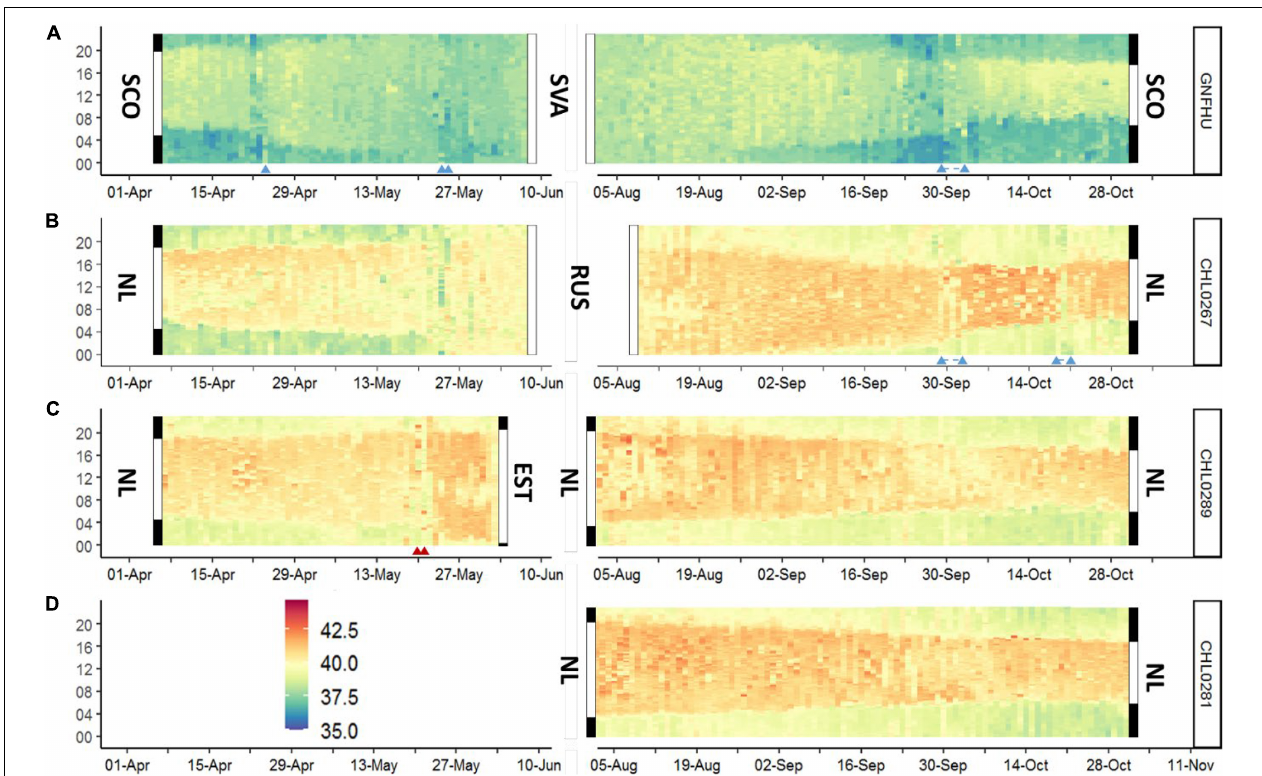
FIGURE 1 | Examples of diel (vertical axis, in hours) and seasonal body temperature (Tb, in ◦ C) patterns in individual barnacle geese (ID given on the right of each plot) from the Arctic-migratory populations (A : Svalbard, B: Russia) and the non-migratory population (D : Netherlands). Panel C refers to an immature individual (CHL0289; born in NL in 2017) that flew in spring 2019 to Estonia. Vertical bars at the start and end of the Tb plots indicate the period of daylight, including civil twilight (white) and night (black) in the wintering and breeding areas (SCO, Scotland; SVA, Svalbard; NL, Netherlands; RUS, Russia; EST, Estonia). Time of day refers to GMT in all panels. Migratory movements are indicated by triangles; if the triangles are connected by dashed lines, then migratory activity was recorded throughout this period. See also Supplementary Figure 3 for further